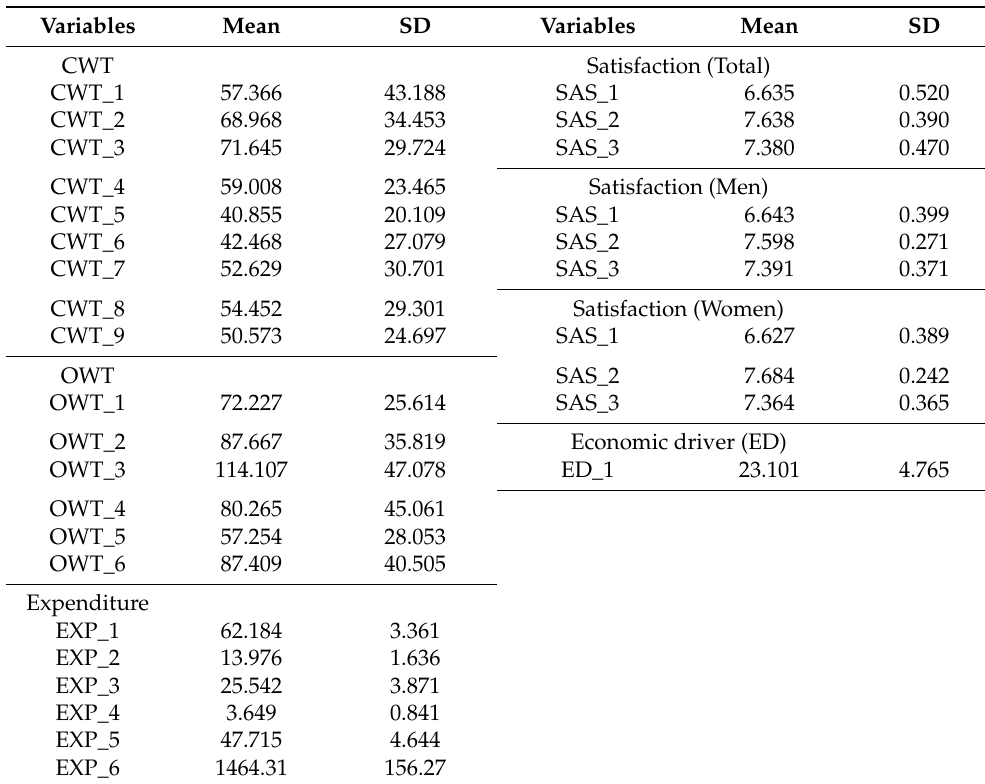
Table 2. Descriptive